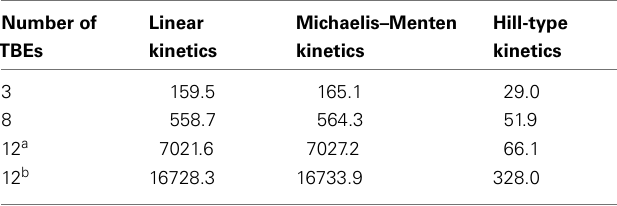
TableA7 | CorrectedAkaike information criterion of the best